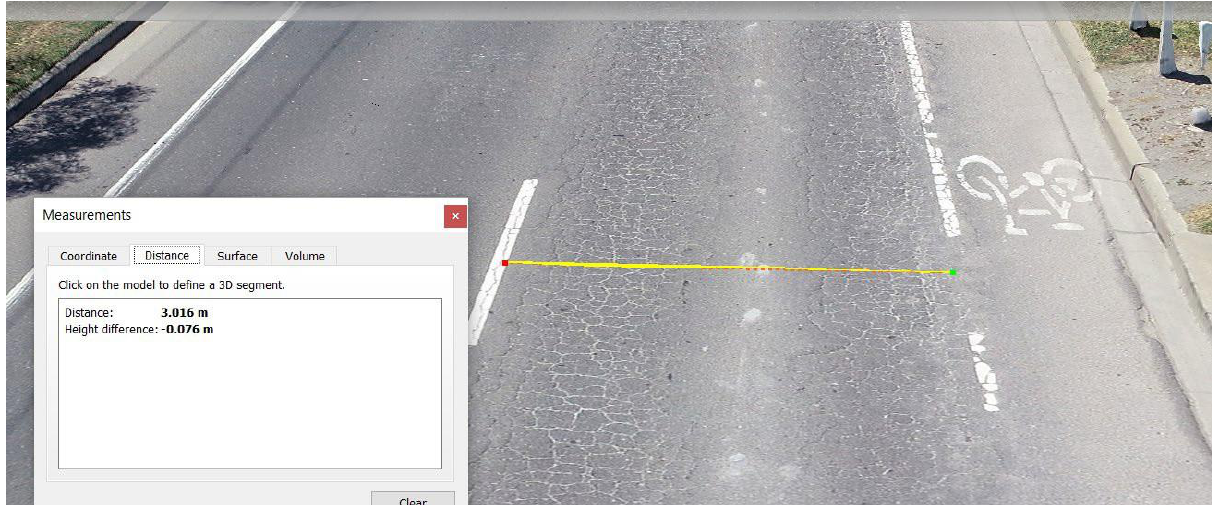
Figure 5. Measurement of bike path to centre line.